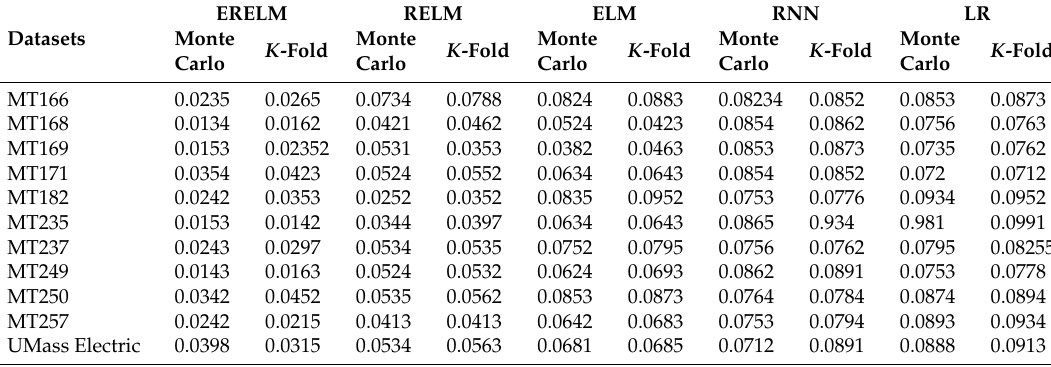
Table 10. Obtained RMSE for half-yearly testing data using ELM, RELM and ERELM by Monte Carlo and K -Fold cross